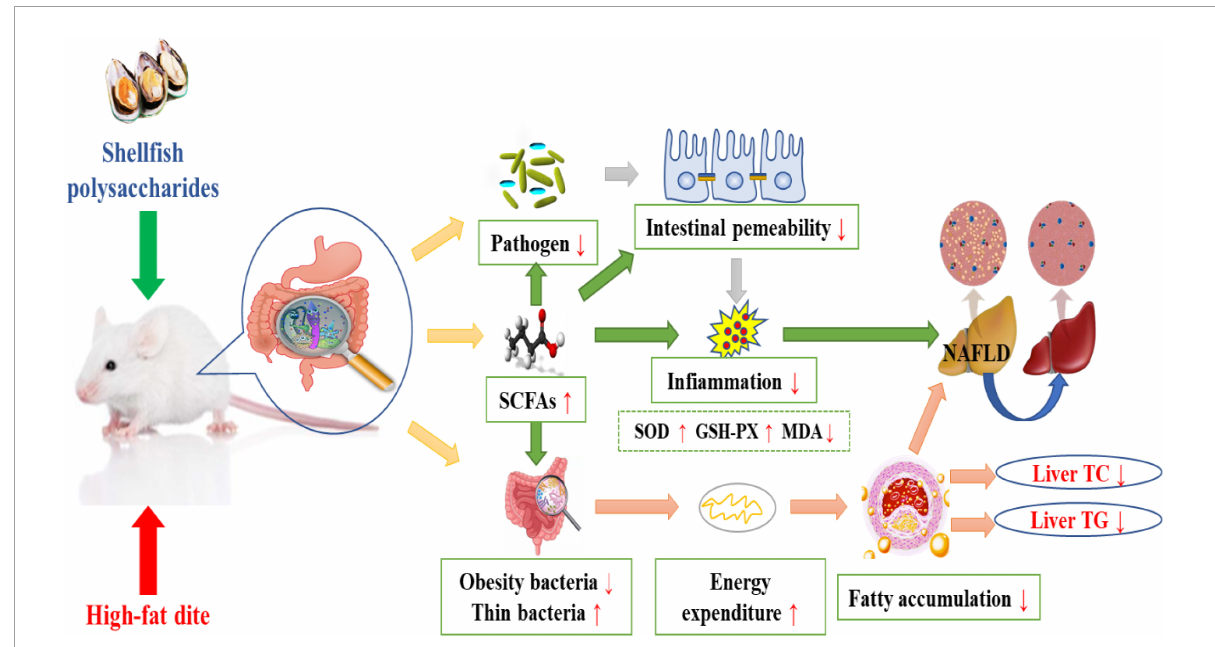
FIGURE2 Mechanism of shellfish polysaccharides in regulating the intestinal microflora and lowering blood lipids.